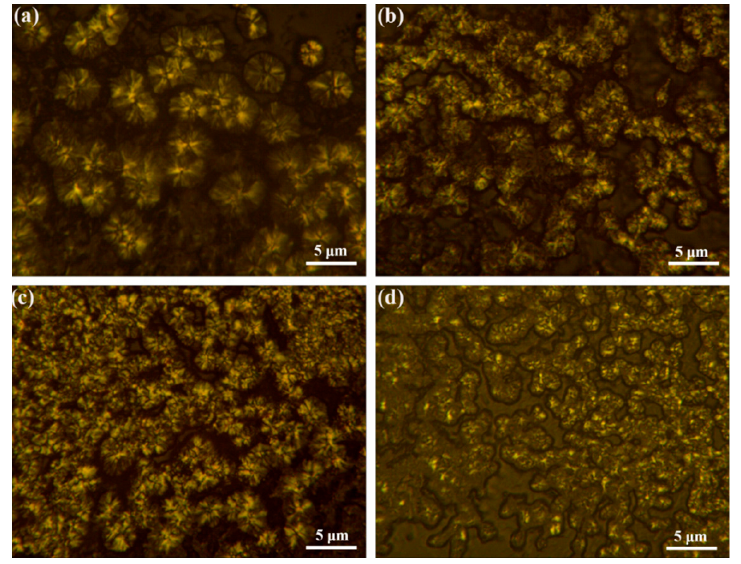
Figure 9. Polaring optical microscopy (POM) of the nanocomposites with different h-BN@(PDA+PEI)